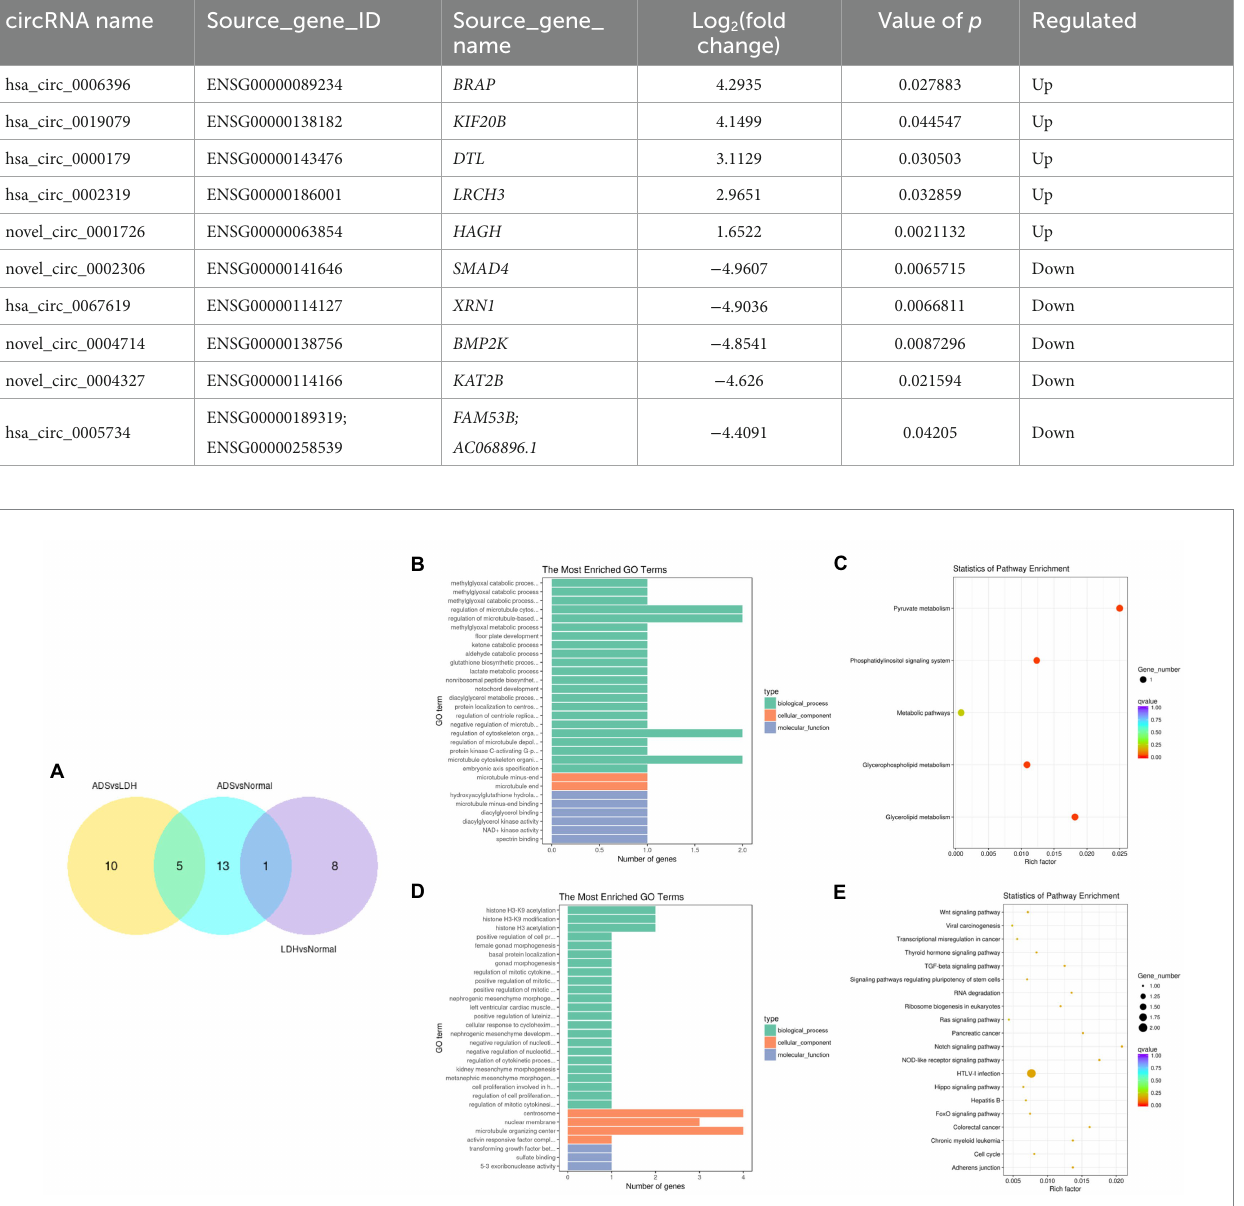
TABLE 7 The top 10 DE circRNAs.